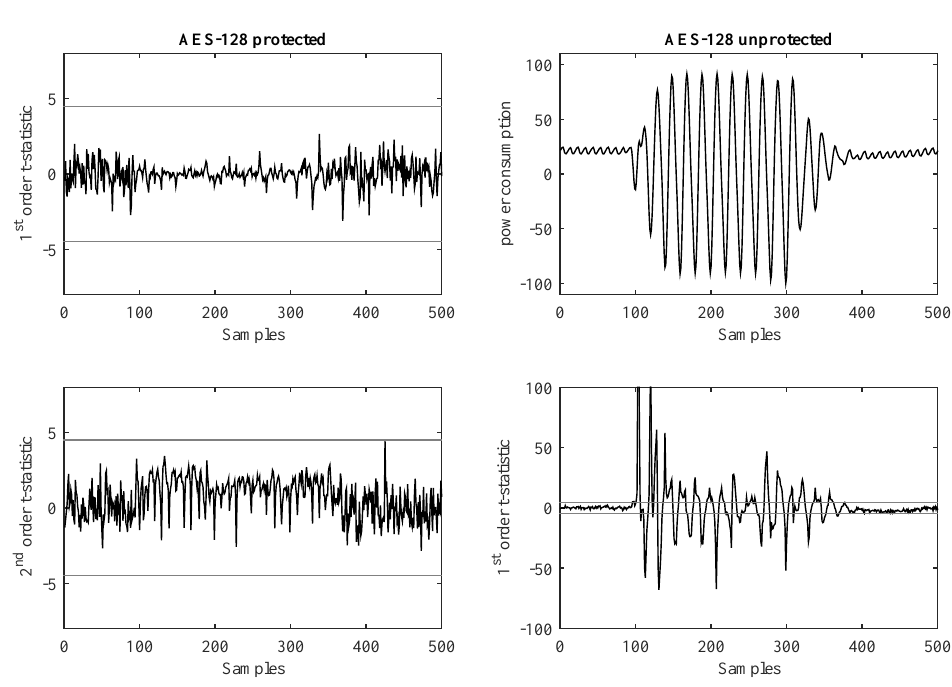
Figure 5: Univariate fixed-vs.-random t-test results for AES-128. The left two plots show the results for the first two statistical order moments using 100 million traces when mask generation is enabled. The upper right plot shows the average trace over 1 million encryption operations, the lower right plot shows the result for the first-order statistical moment using 1 million traces when mask generation is